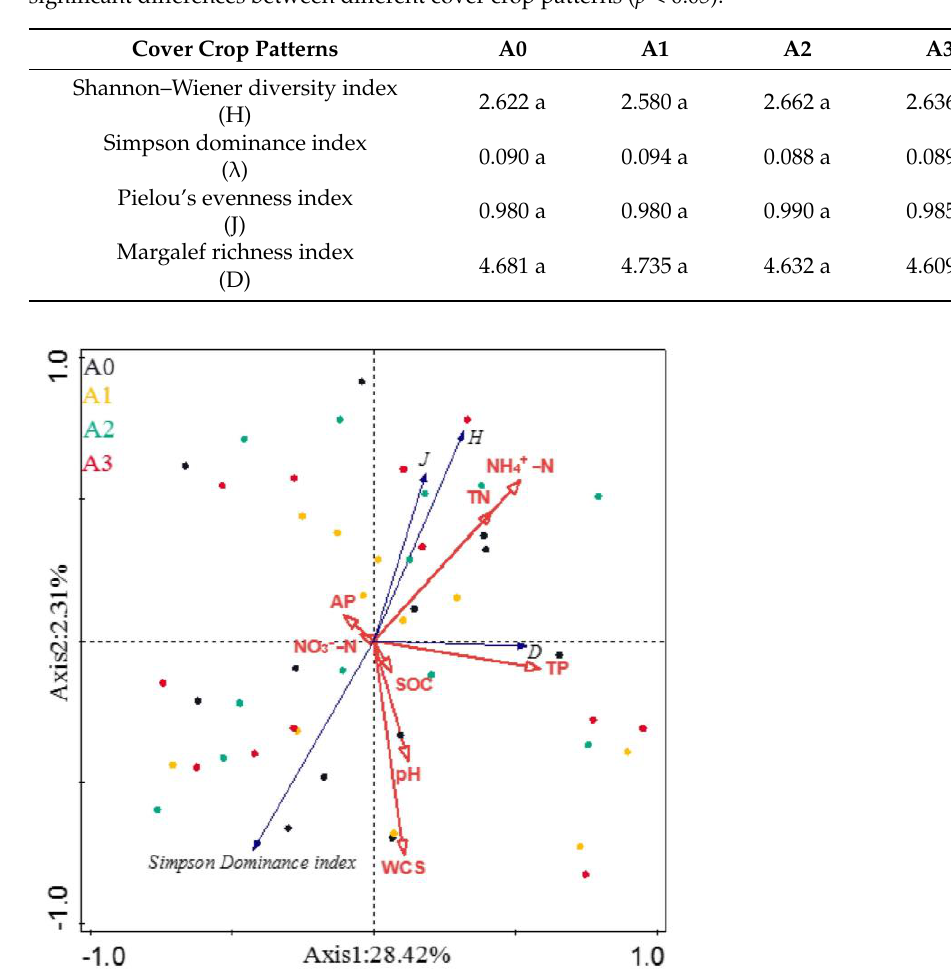
Table 3. Ecological indices of the microbial community. Different lowercase letters indicate the significant differences between different cover crop patterns ( p < 0.05).